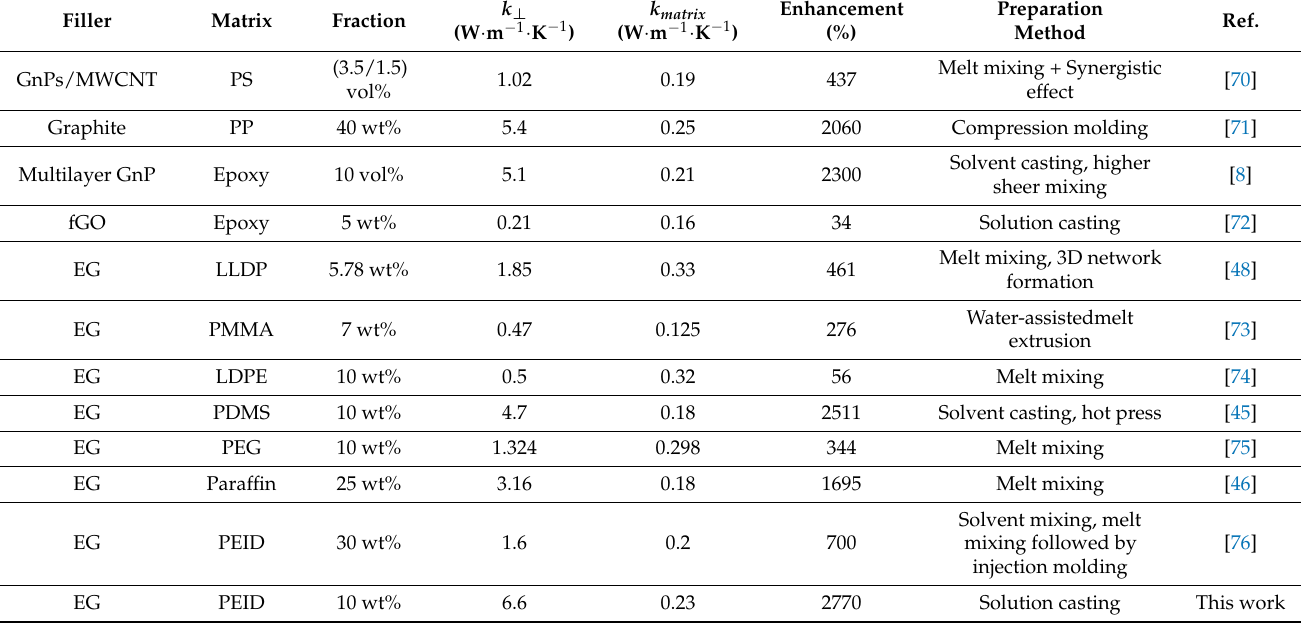
Table 1. Comparison of k ⊥ for different polymer graphene and EG − polymer